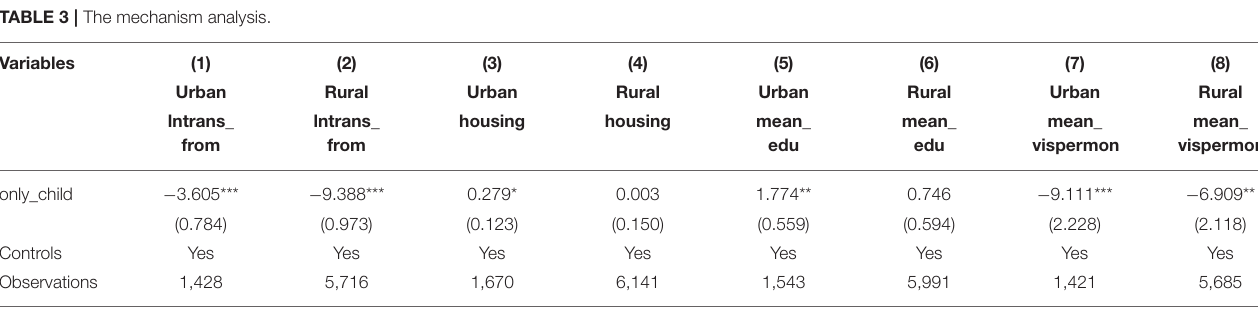
TABLE 3 | The mechanism